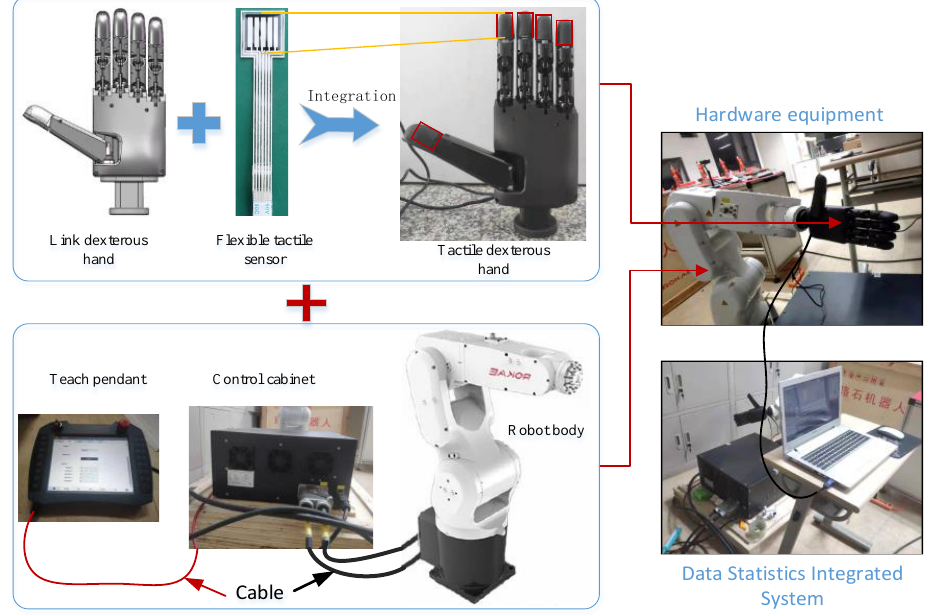
Figure 2. Tactile data collection platform.